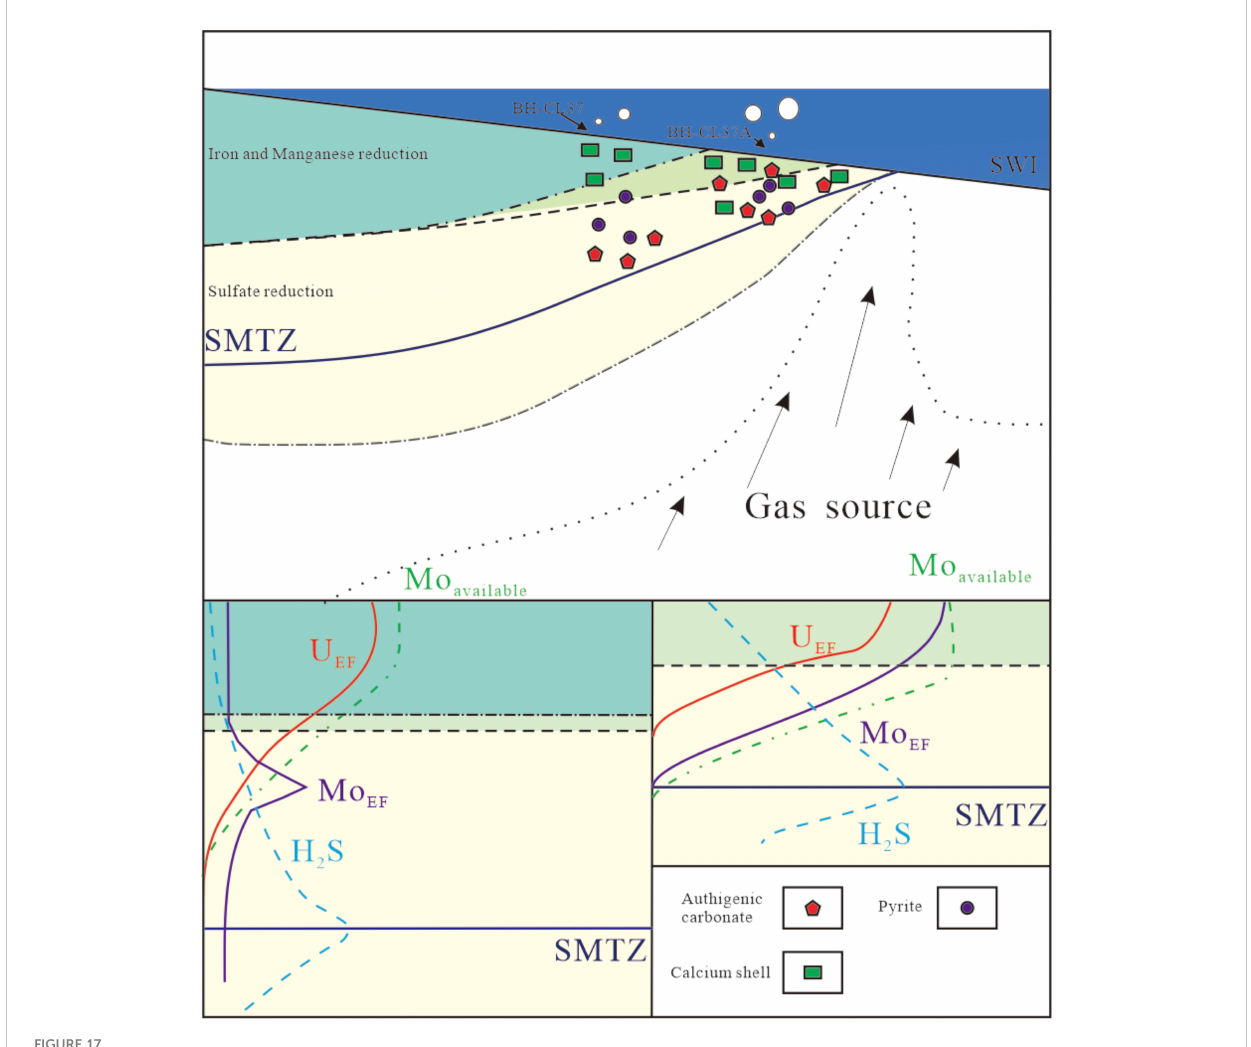
FIGURE 17 Response of different cold seep activities in BH-CL37 and BH-CL37A to